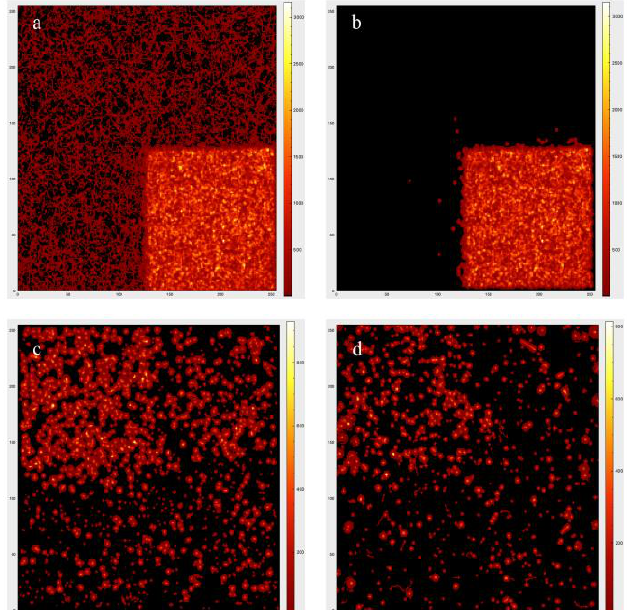
Fig. 4. (a) Integration window of thermal neutron measurement without any cluster cuts. (b) The same integration window as (a) but after cuts were applied. Almost no signal outside the LiF region. (c) Measurements with AmBe